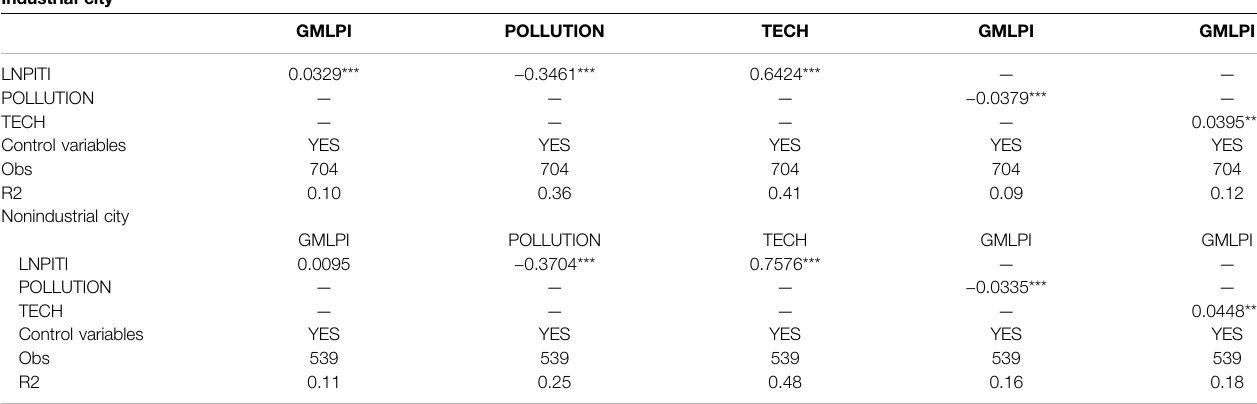
TABLE 5 | Regression results of the industrial city and nonindustrial city. Industrial city